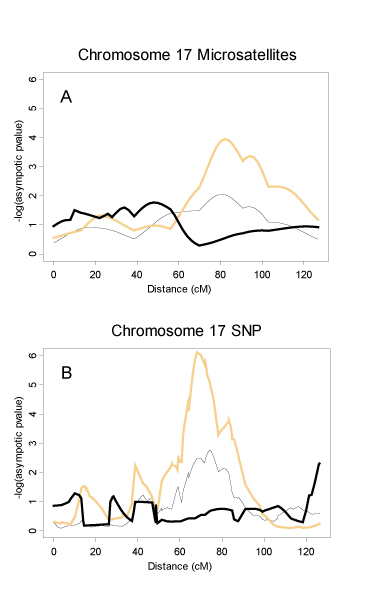
Sib-pair QTL results of P300 amplitude, stratified for alcoholism. Linkage results are shown for MS markers (A, N = 735 sib-pairs) and SNPs (B, N = 718 sib-pairs). The negative log of the asymptotic p-value is plotted over distance in centimorgans (cM). Results are shown for the entire group (thin black line), the alcoholism subgroup (thick tan line), and the non-alcoholism subgroup (thick black line). Sample sizes in sib-pairs are 173 for MS alcoholism, 104 for MS non-alcoholism, 170 for SNP alcoholism, and 103 for SNP non-alcoholism subgroups.